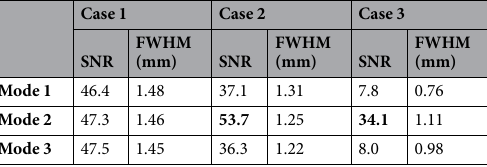
Table 2. In Case 1, Mode 1–3 provided USF images with similar SNRs; in both Case 2 and Case 3, USF images achieved the highest SNRs when the Mode 2 was adopted. In all cases, FWHMs remained similar in the three